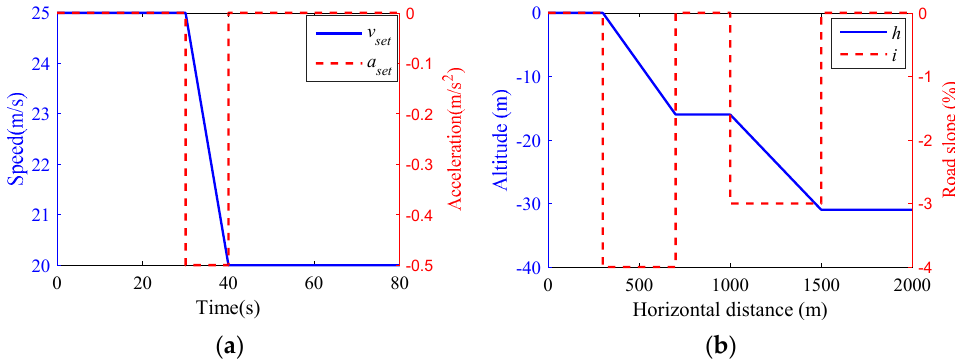
Figure 10. Profiles of leading vehicle movement and road slope in scenario 2. ( a ) Leading vehicle movement. ( b ) Road slope.